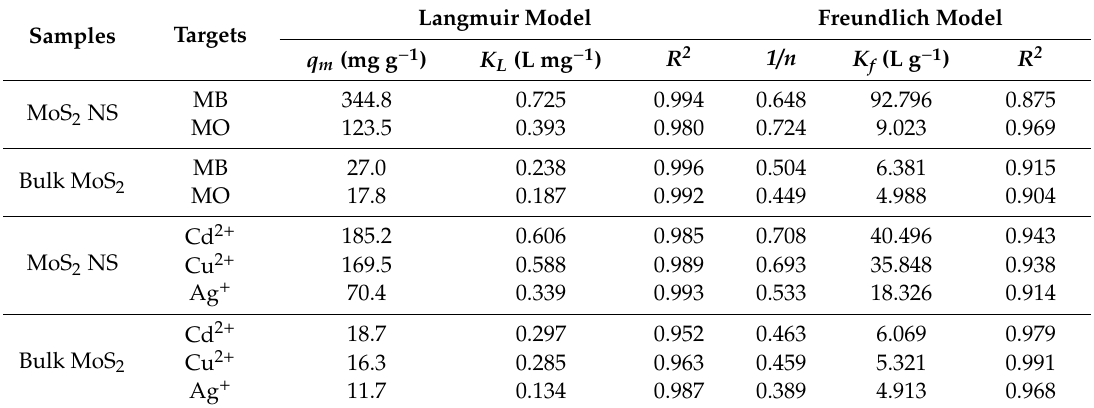
Table 1. Fitted parameters for the adsorption of dyes and heavy metals on MoS 2 NS and bulk MoS 2 . Langmuir Model Freundlich Samples Targets